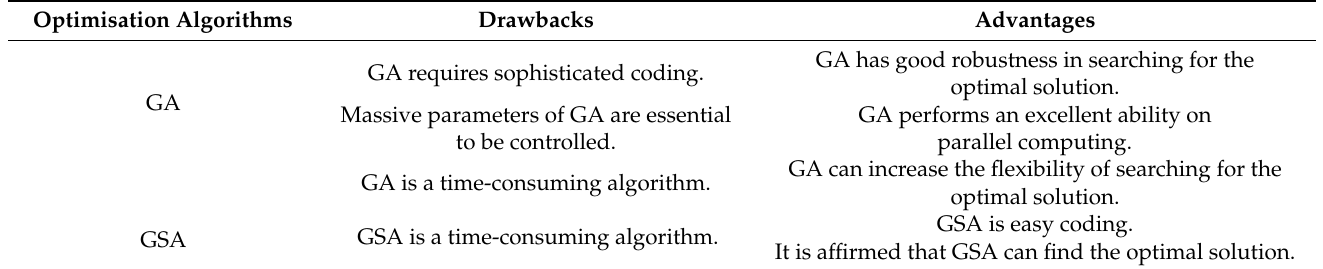
Table 4. Characteristics of GA and